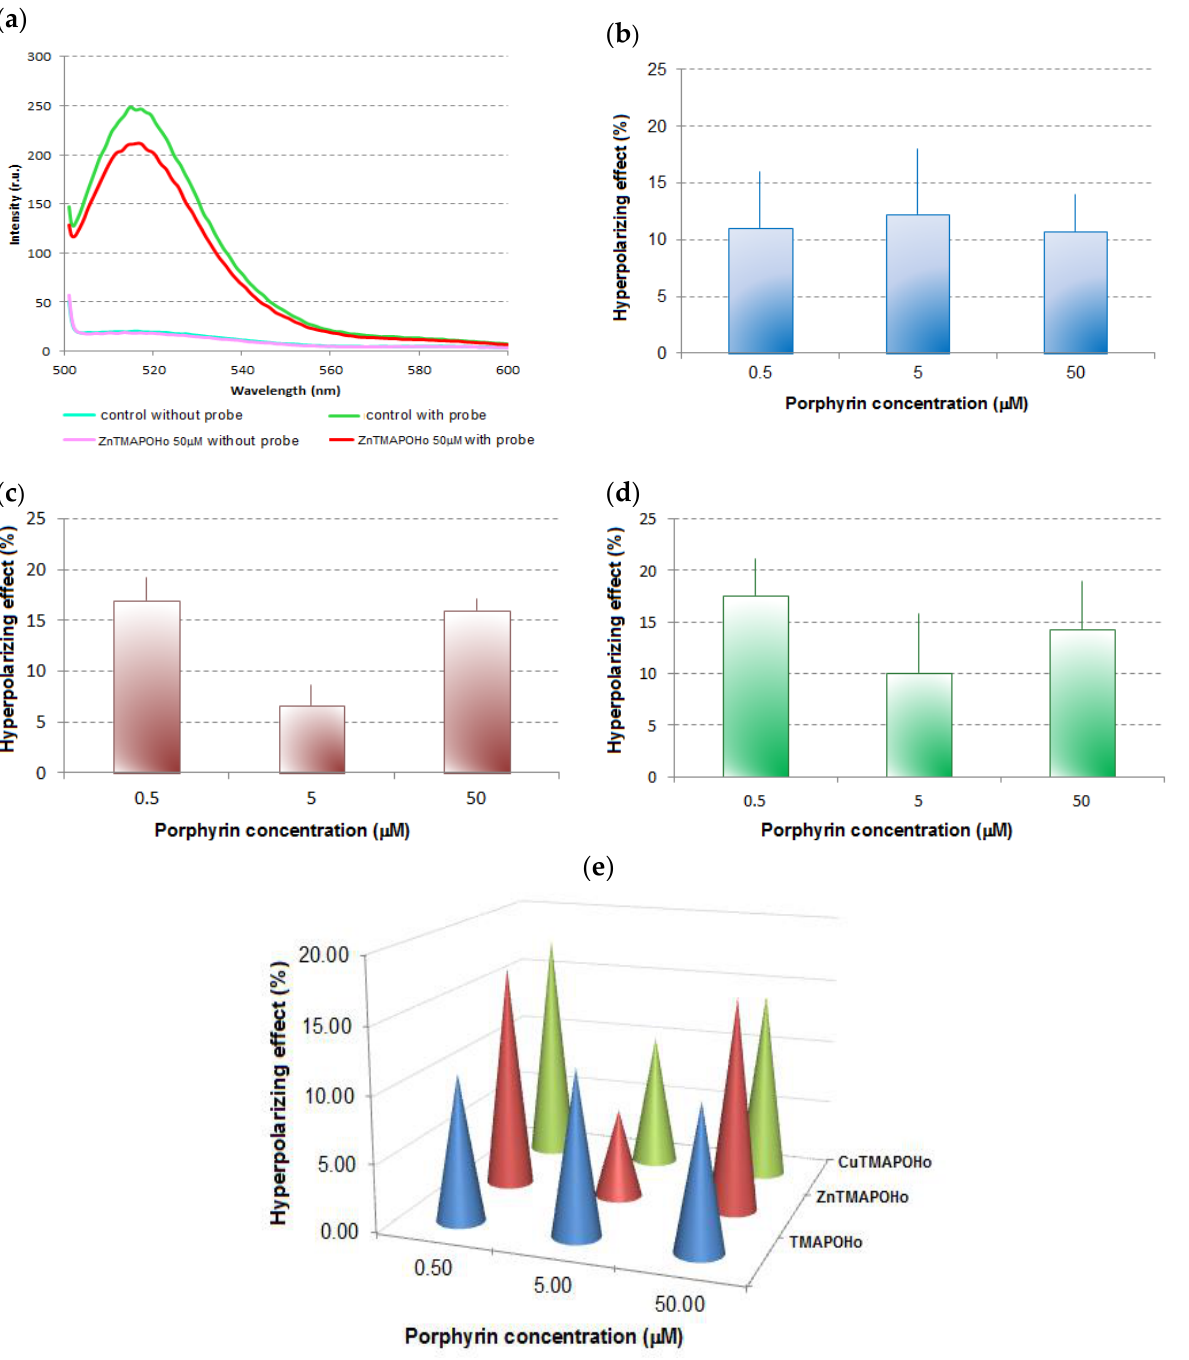
Molecules 2023 , 28 , x FOR PEER REVIEW 5 of 25 Figure 2. Representative effects of porphyrinic compounds on the transmembrane potential of U937 cells. ( a )—Fluorescence spectra of U937 cells, with and without the potential-sensitive probe DiBAC 4 (3), when Zn(II)TMAPOHo was tested ( control without probe, control with probe, 50 μ M ZnTMAPOHo without probe, 50 μ M ZnTMAPOHo with probe);